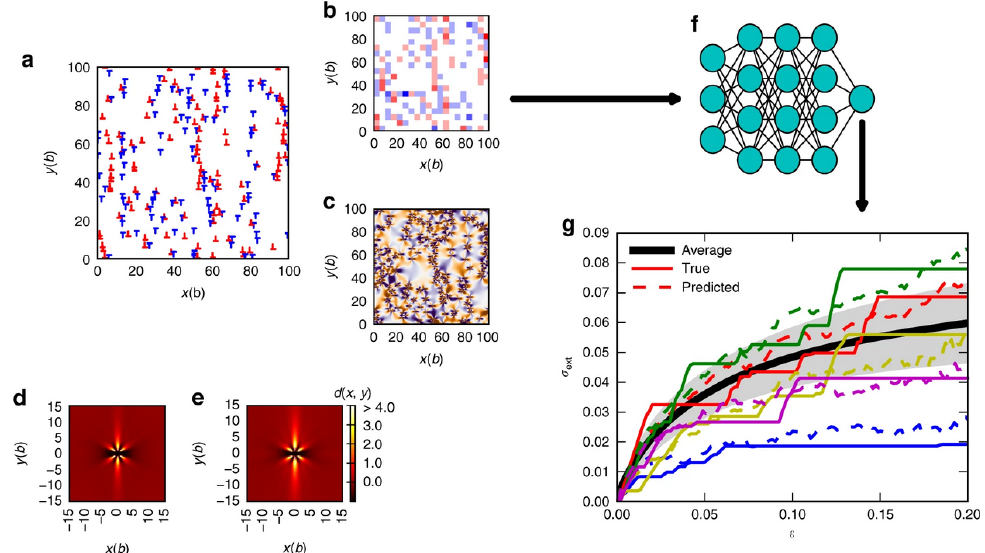
Figure 8. Workflow showing an ML approach for the prediction of mechanical properties of materials, based on DDD simulation data. Features are selected from the initial dislocation microstructure ( a ) like the geometrically necessary dislocations (GND) density of positive and negative dislocations ( b ) and the internal stress field ( c ). After defining, as initial states, relaxed random configurations (pair correlation function shown in ( d )), or pre-deformed dislocation configurations ( e ), the authors trained a neural network (NN) ( f ) in the prediction of stress/strain curves based on these descriptors. Results showing NN predictions against true stress/strain curves are shown in ( g ). The figure was reproduced after [167] based on the Creative Commons Attribution 4.0